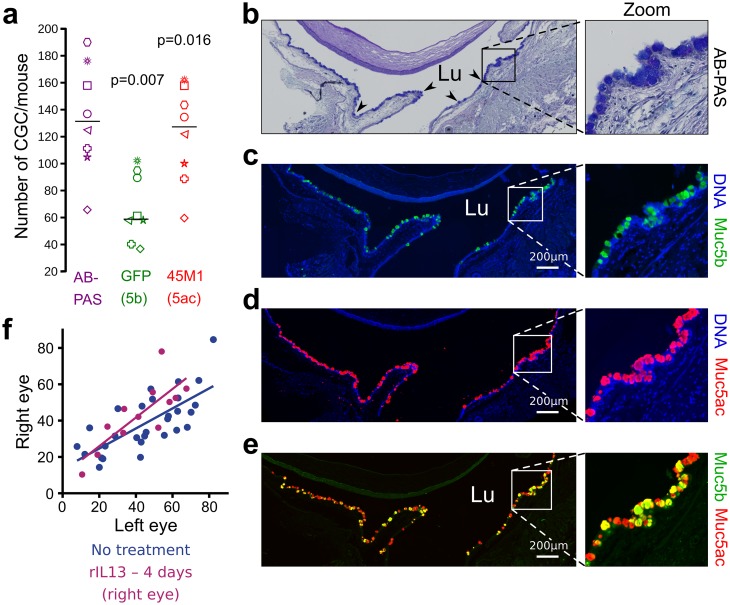
Similar GFP activity in eye conjunctiva after topical application of rIL13.(a) The number of CGC, GFP+ (Muc5b) and 45M1+ (Muc5ac) CGC were counted using serial sections from untreated mice, one for AB—PAS staining and the other for immunofluorescence staining using an anti-GFP antibody and the anti-Muc5ac antibody (45M1). N = 8 transgenic mice; two-sided Permutation test, P = 0.007 and P = 0.016, respectively. Each symbol represents one mouse. Sample median is shown as horizontal bars (b-e) Representative AB—PAS histological section and immunohistochemical serial sections stained with anti-GFP (Muc5b, green) and anti-Muc5ac (red) from a Muc5bGFP/+ mouse conjunctiva showing GFP+ and Muc5ac+ CGC. The four arrowheads illustrate several goblet cells of the conjunctiva. Lu, lumen; scale bar, 200 μm. (f) Number of GFP+ CGCc determined by pCLE analysis in each eye of 12 mice (purple) which received rIL13 in the right eye and PBS in the left for 4 days in comparison to 29 mice (blue) without any treatment. Statistical analysis was performed using paired t–test.